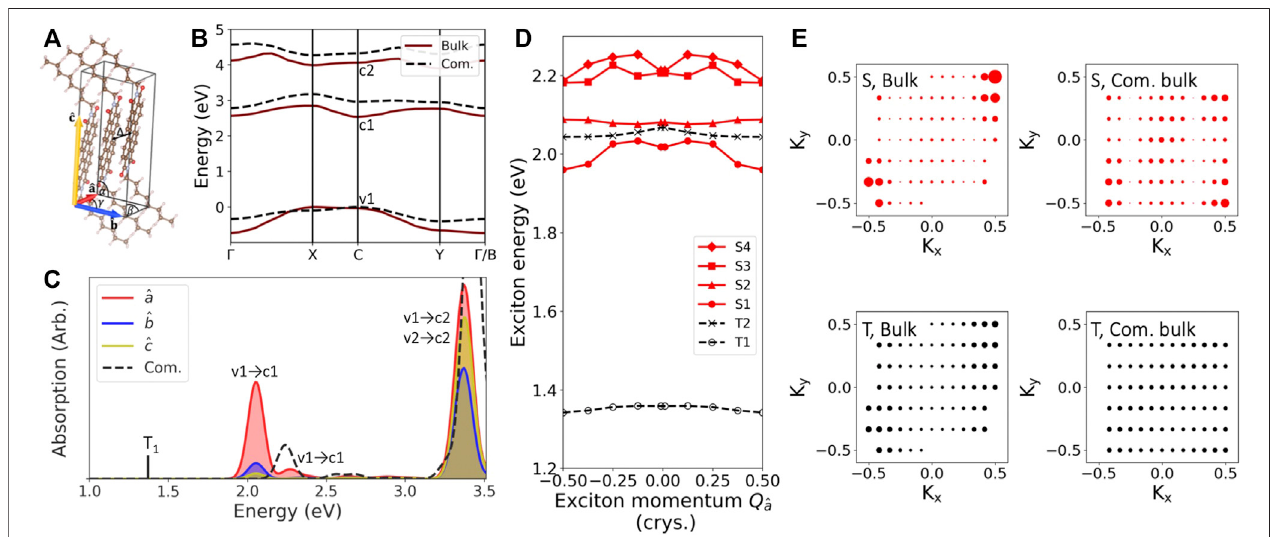
FIGURE2| Structuralandexcitationpropertiesofthebulk C8-PDI molecular crystal: (A) Theunit cellshowingthecrystallographicparameters,which aremodi fi ed among the various bulk structures examined. Δ denotes the intermolecular distance. (B) Computed GW quasiparticle bandstrcuture for the bulk (solid red) and the commensurate bulk (dashed black) structures. (C) Computed GW-BSE absorption spectra with the polarization of the light aligned along different cell directions. The low-lying triplet state is also shown (black line). Solid lines are for the bulk structure, and dashed black line is for the commensurate bulk structure. (D) Exciton bandstructure of the four lowest singlet states (solid red) and the two lowest triplet states (dashed black) of the bulk structure. (E) Exciton coef fi cients as a function of electron momentum in the ( K x , K y ) crystal plane for the lowest singlet and triplet states, of both the bulk and the commensurate bulk structures.